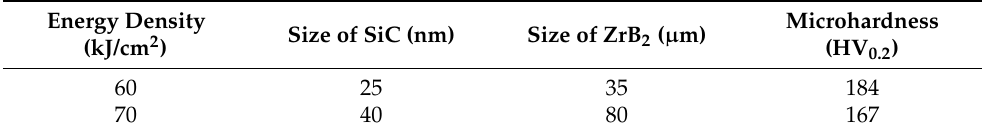
Table 3. Size of the reinforcement and microhardness of the composite under different laser energy